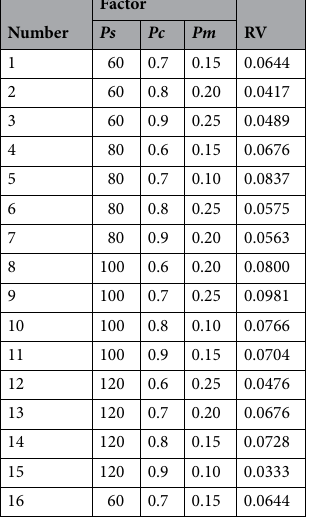
Table 7. Orthogonal matrix and RV